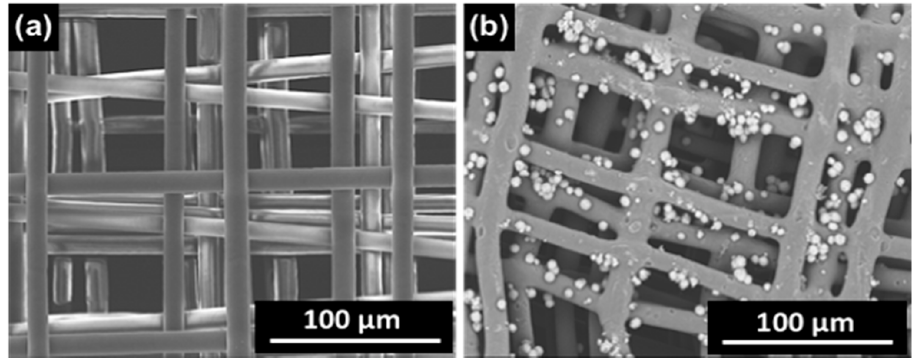
Figure 1. SEM images of melt electrowritten medical-grade polycaprolactone (PCL) scaffolds ( a ) as manufactured and ( b ) after coating with calcium phosphate (CaP) particles.